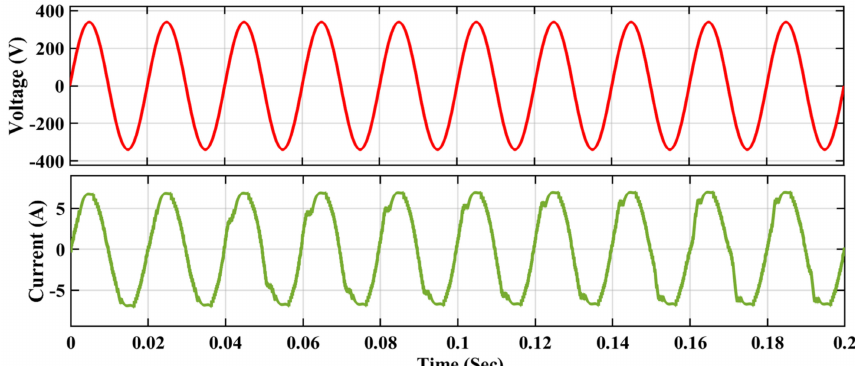
Figure 17. Grid voltage and grid current waveforms with HHO-PI controller.